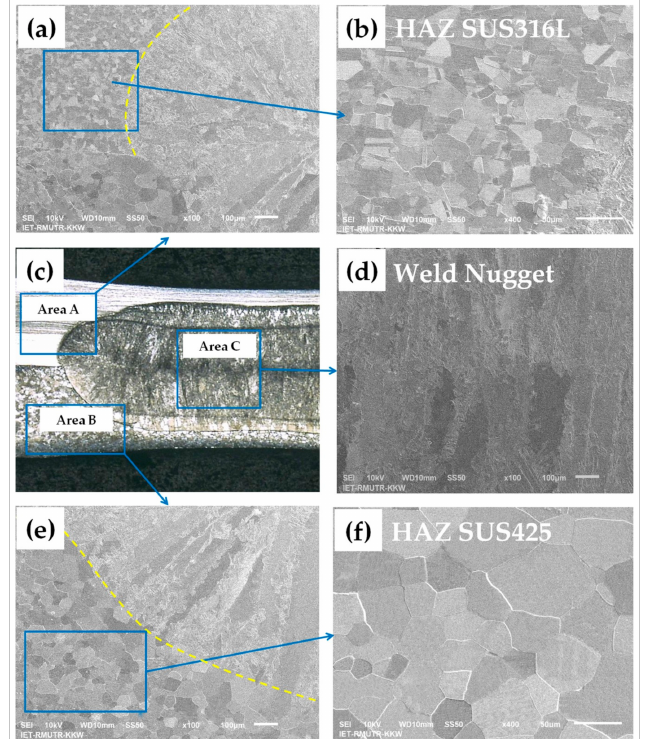
Figure 14. Cross-sectional microstructure of weldment under a 7.0 kA weld current and 25-cycle welding time.